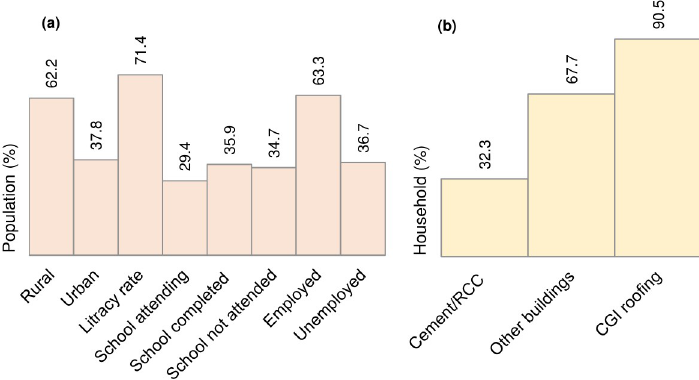
Fig 2. Segmentation of flood vulnerability attributes. (a) Demographic projection, (b) Household